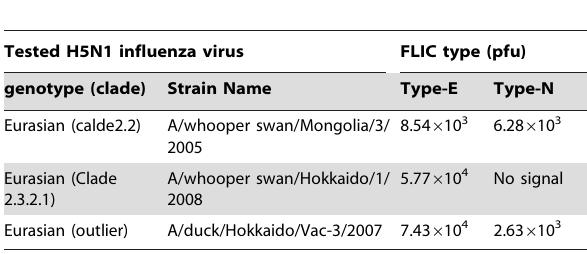
Table 5. LODs of H5 FLIC for H5 subtypes of influenza A viruses.